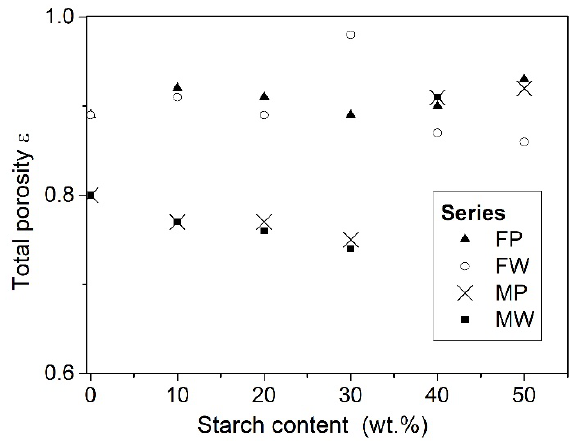
Figure 4. Dependence of the total porosity on the nature and composition of the carbon precursor.